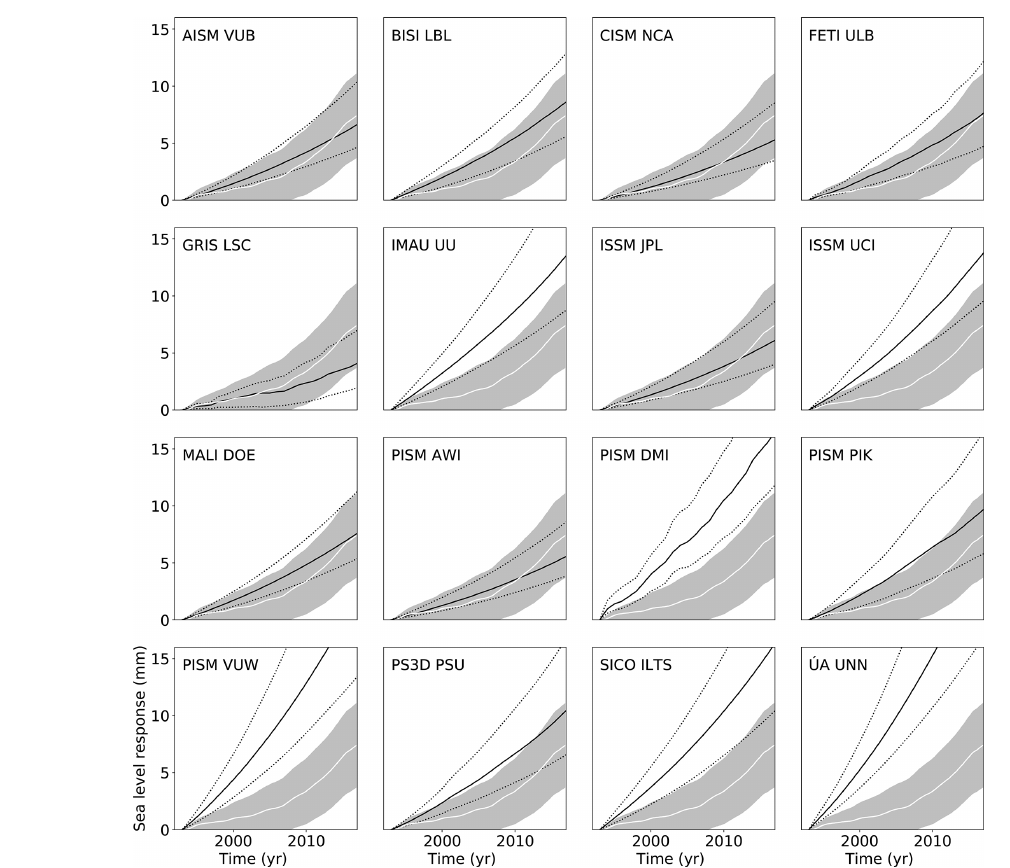
Figure 6. Hindcasting observed sea level contributions and modelled sea level contribution of Antarctica from the different ice sheet models. The solid black line represents the median contribution between 1992 and 2017 with the 66th percentile (first standard deviation) around the median. The grey shading represents the uncertainty range of the observed contribution of Antarctica (white solid line) following Shepherd et al.